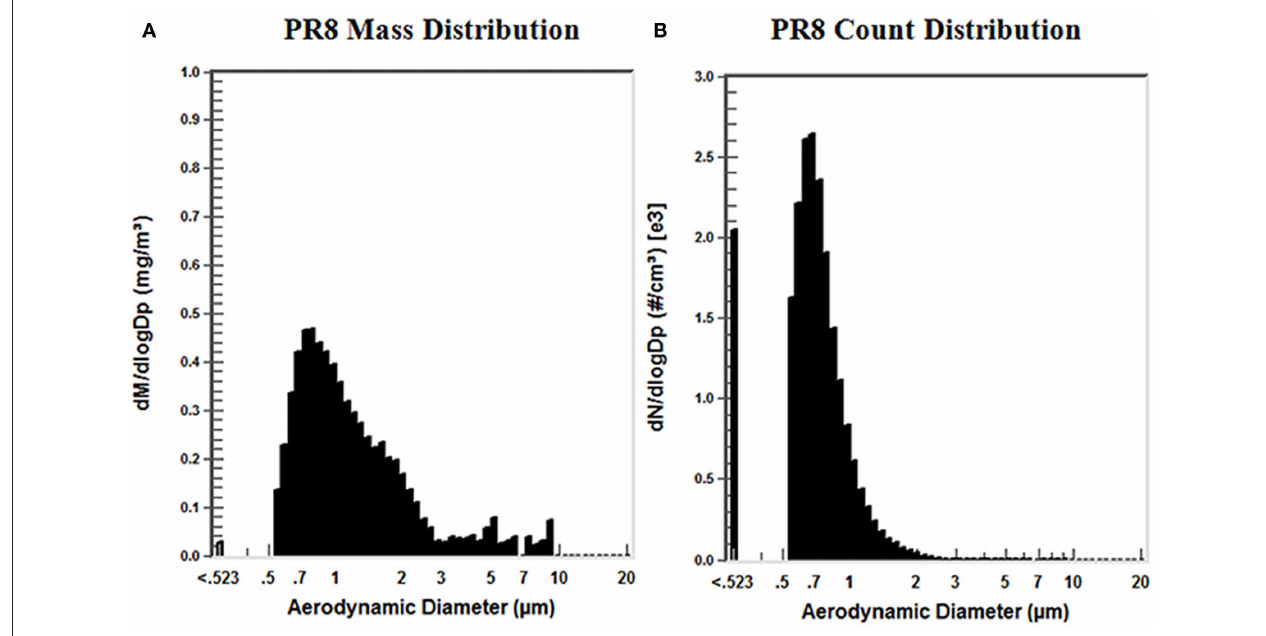
FIGURE 1 | Distribution of particle size mass and count in PR8 aerosols. APS samples collected from the challenge plenum were used to determine, (A) the distribution of particle size mass; dM is the mass of the particles collected in the range (total mass) and dlogDp is the difference